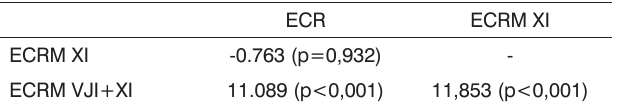
Figura 1. Recorrência regional em função do tipo de esvaziamento radical.